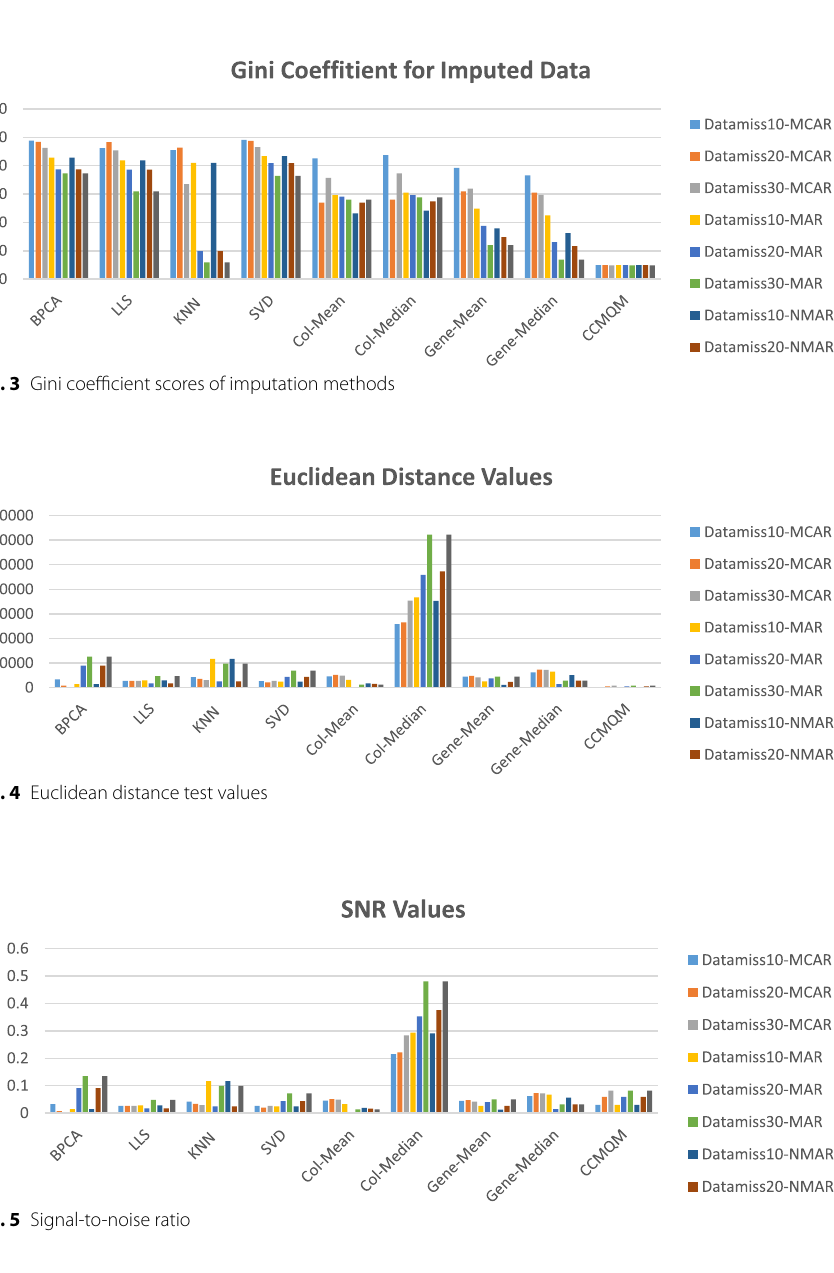
Fig. 2 Period taken for each imputation method